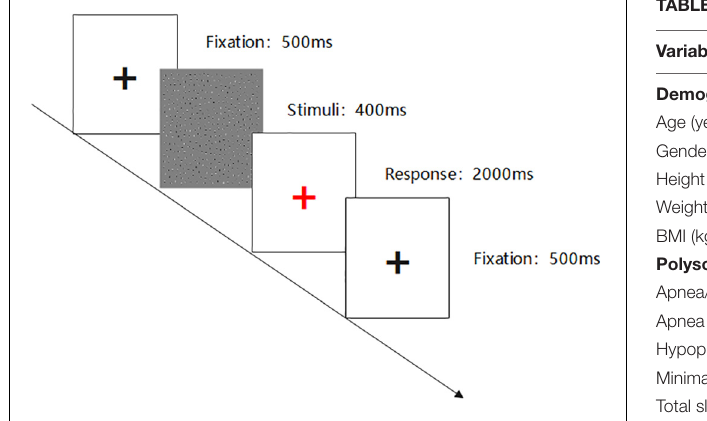
FIGURE 2 | Contour integration experimental flowchart.